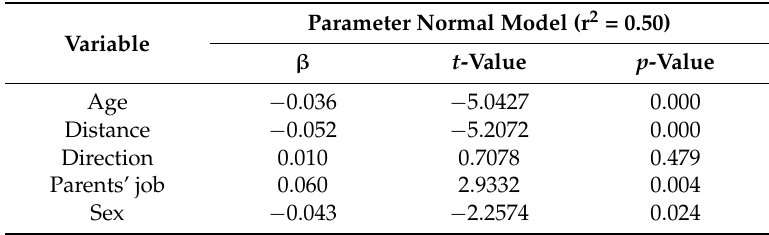
Table 4. Determinant of blood lead as assessed by multiple regression